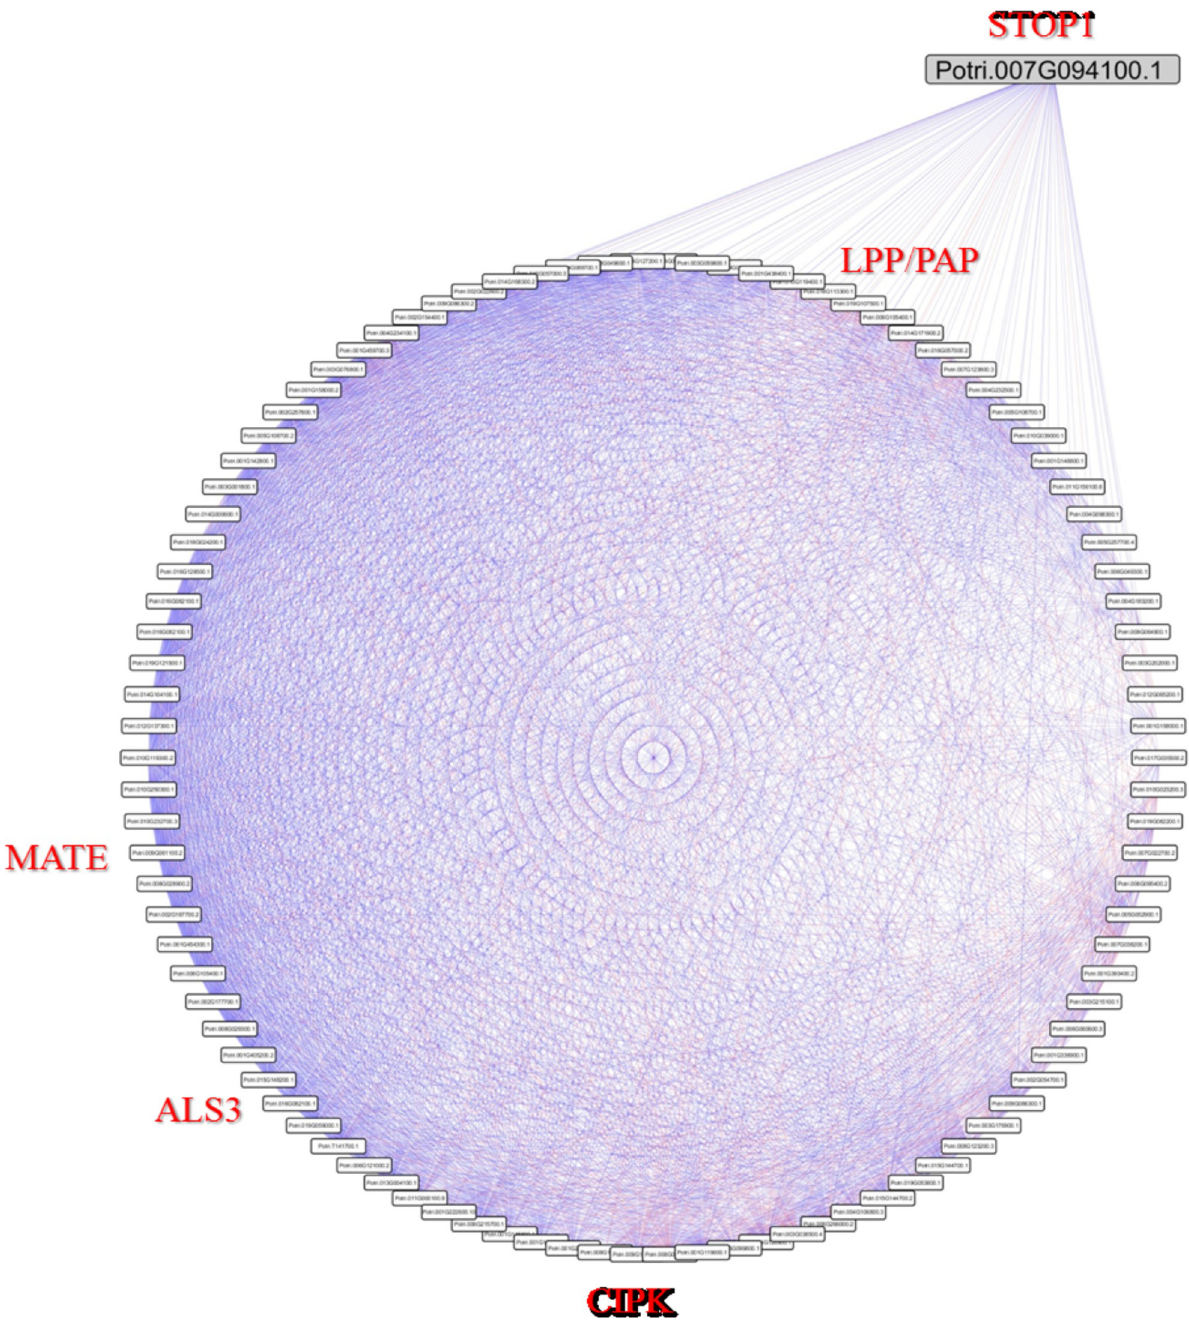
Fig 3. Network of Potri.007G094100.1 . Direct connections of the Potri . 007G094100 . 1 gene, annotated as transcription factors of the C2H2-zinc finger family, orthologous to AtSTOP1 from A . thaliana and the main hub between the transcription factors identified. Blue lines refer to positive correlations and red lines to negative correlations between the Potri . 007G094100 . 1 gene and the other 100 genes to which it is correlated, with ρ � |0 . 8|